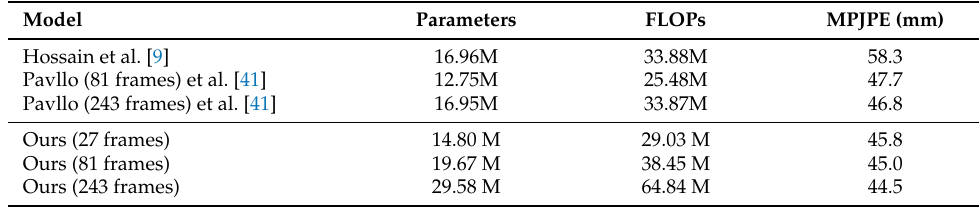
Table 4. Computational complexity of various models under protocol